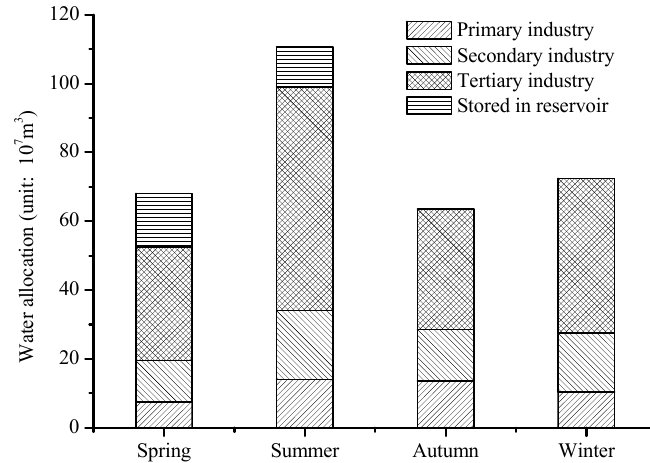
Figure 5. The allocation results of water sources and the quantity stored in reservoirs under violating constraint α = 0.15.